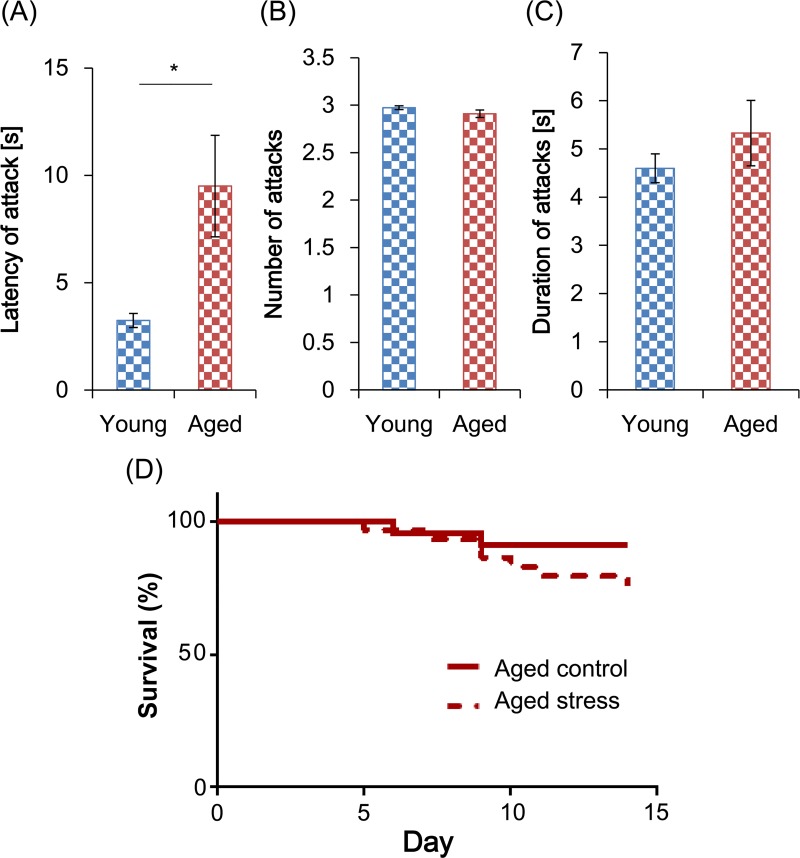
Latency and number of attacks by CD1 mice on experimental mice.(A) The latency to the first attack, (B) number of attacks, and (C) duration from the first to the third attack are shown. Values during each defeat session were averaged for each subordinate mouse and compared between age groups. Data are presented as means ± standard error of the mean (SEM) (young, n = 22; aged, n = 22). *: p < 0.05 (Aspin–Welch’s t-test). (D) Kaplan–Meier survival curves from the aged groups during Days 1–14 are shown.